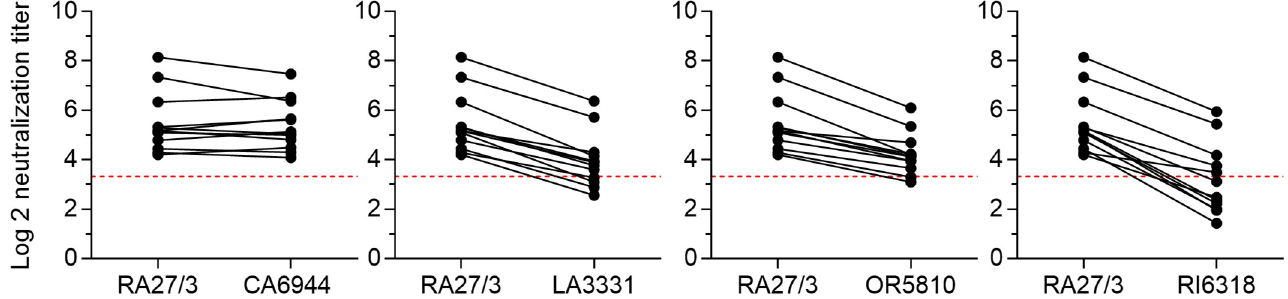
Fig 9. Neutralization of iVDRV isolates by sera from immunized immunologically-competent individuals and PID patients. Comparison of neutralization titers in 10 sera from healthy MMR vaccinees against iVDRVs and RA27/3. A neutralization titer was expressed as a log2 reciprocal of the serum dilution that protected 50% of the input virus. The cutoff of the assay (NT = 10) was depicted by the red dashed line.